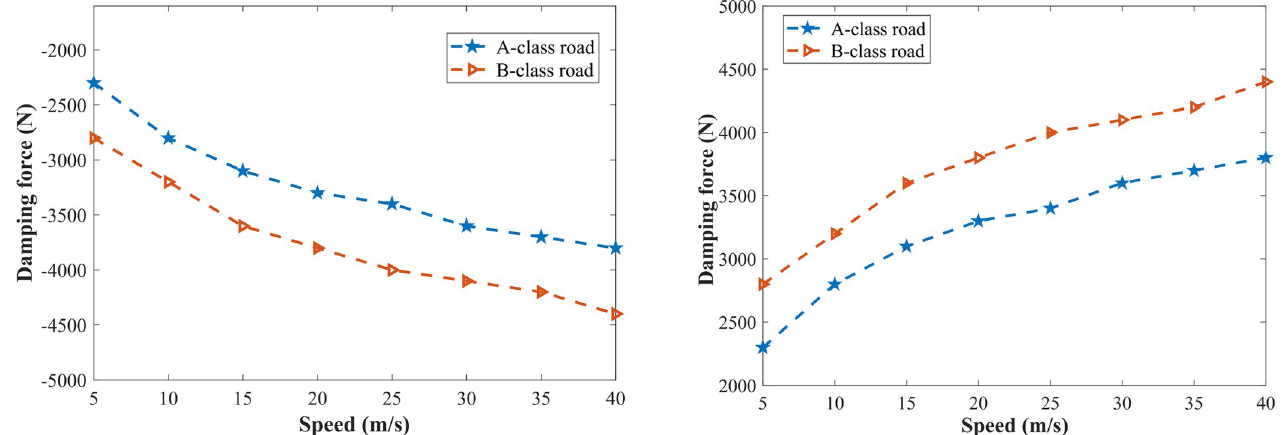
Fig 20. Maximum damping forces required for shifting the vehicle body by 5 cm. (A) Vehicle body raises; (B) Vehicle body drops.